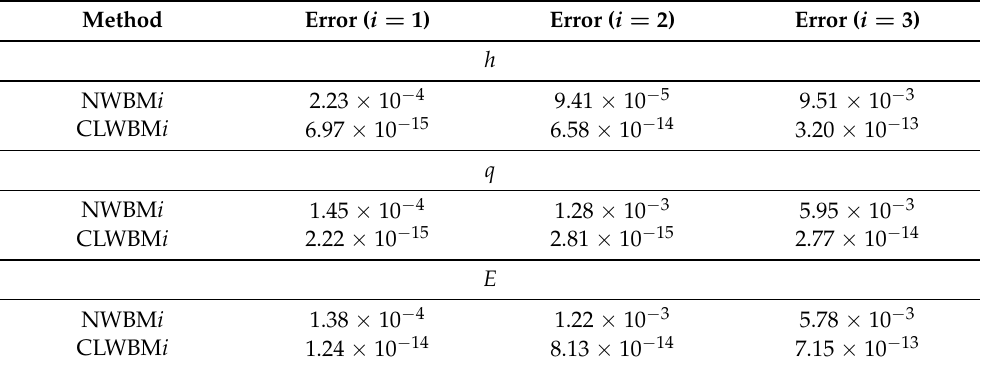
Table 18. Test 5.1. Differences in L 1 -norm with respect to the stationary solution for NWBM i and